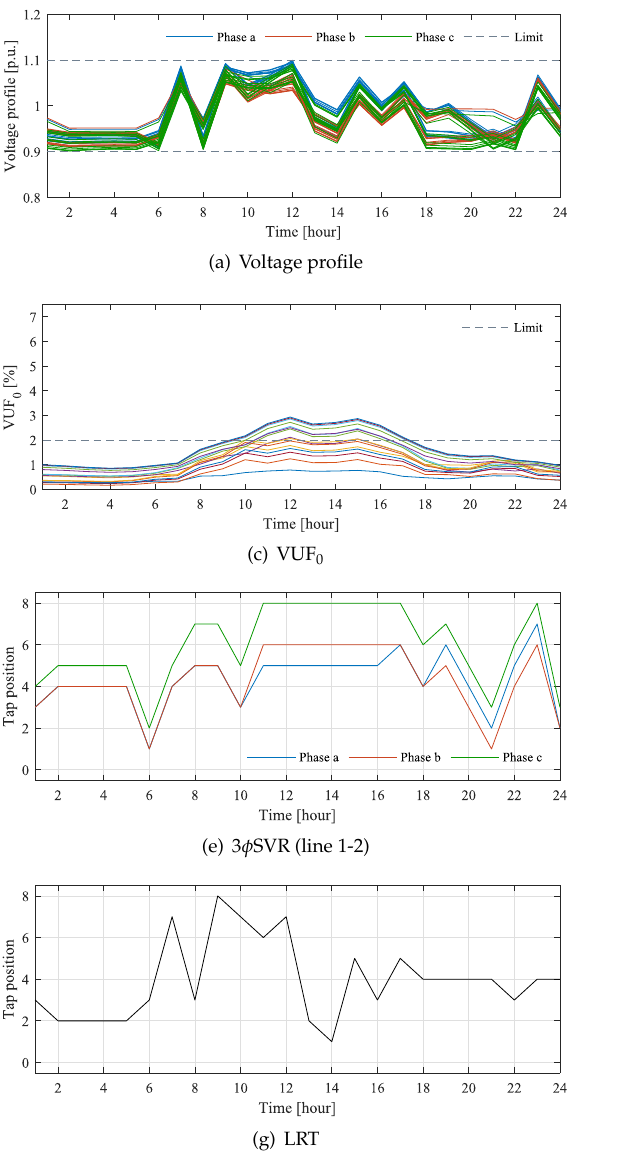
Figure 5. Simulation result of Case 1: minimize VUF; the different colors in ( b – d ) refer to different buses. The VUF satisfies the constraint value for all-day, but the maximum values of VUF 0 and PVUR are above 2%.